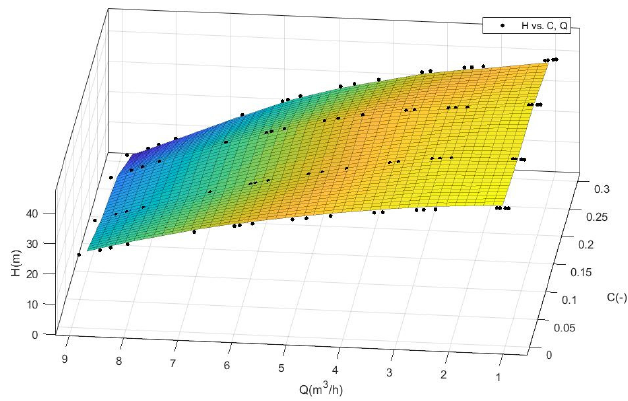
Figure 3. Fitting graph of pump Q-H data.